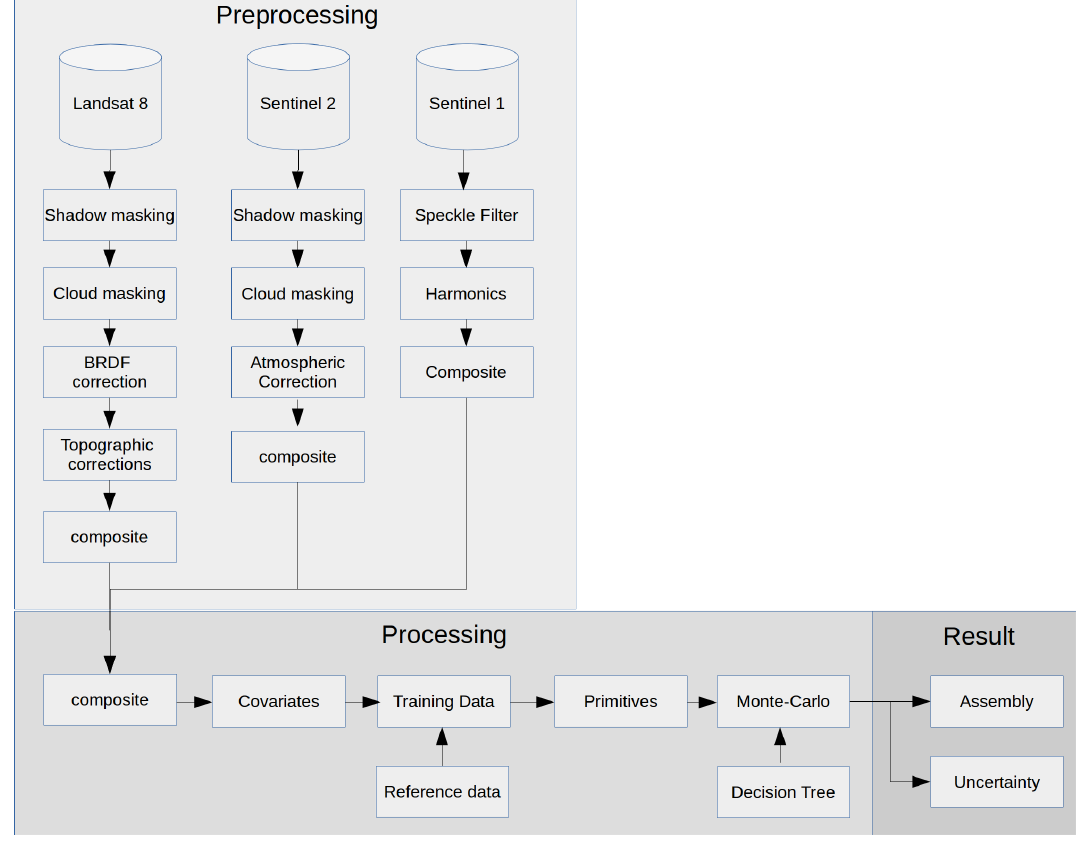
Figure 3. Overall workflow used in this study divided in pre-processing, processing, and result